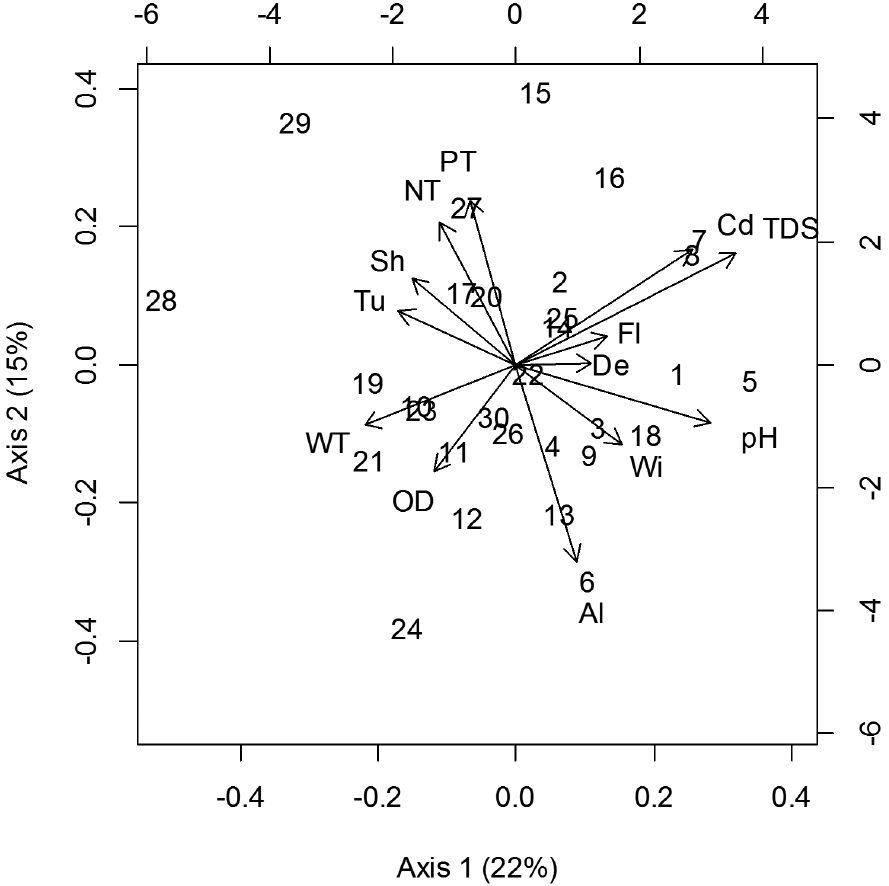
Figure 2. Principal Component Analysis (PCA) of environmental variables streams analyzed. PT – Total Phosphorus, NT – Total Nitrogen, CD – Conductivity, OD – Dissolved Oxygen, pH – Hydrogenionic Potential, WT – Water Temperature, Tu – Turbidity, TDS – Total Dissolved Solids, De – Depth, Fl – Flow, Sh – Shading, Wi – Width, Al –